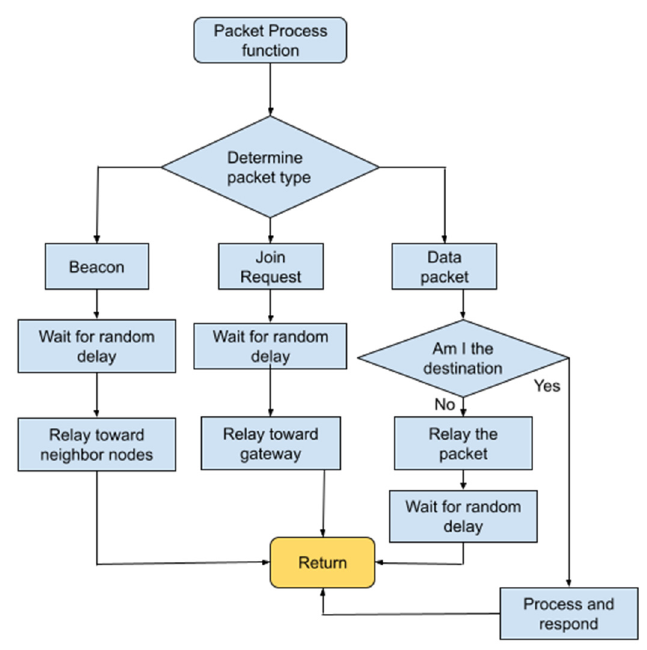
Figure 13. Packet process function.